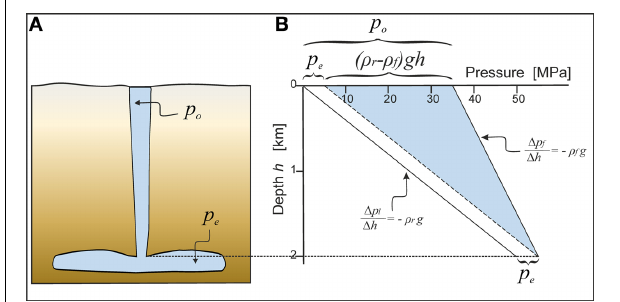
FIGURE 9 | (A) In an elastic crust (cf. Figure 5 ), the weight of the rock above the source is supported by the fluid pressure in the source. In the roof of the source, a lithostatic state of stress is assumed that is, p l = σ 1 = σ 2 = σ 3 . In the fluid source an internal fluid excess pressure p e may occur (in excess of the lithostatic stress), and if p e reaches the local in situ tensile strength T 0 of the rock in the roof, the fluid source ruptures and a hydrofracture is initiated (Equation 3). In the propagating hydrofracture, the fluid pressure in excess of the normal stress on the fracture plane, which for extension fractures is the minimum principal compressive stress, σ 3 , is referred to as overpressure p o . (B) Illustration of the buoyancy effect that leads to the fluid overpressure p o in the hydrofracture being different from the excess pressure p e because the density of the host rock, ρ r , is different from that of the fluid, ρ f . In the roof of the fluid source the total fluid pressure p f at the time of rupture is equal to the sum of the lithostatic stress p l and the excess pressure p e (Equation 3). Assuming a fluid density − 3 (water), according to the weight gradient (cid:3) p f = − ρ ρ f of 1000kg m f g (cid:3) h the fluid pressure inside the hydrofracture decreases upwards with roughly 10MPa km − 1 . The lithostatic stress p l in the host rock, however, decreases according to the equation (cid:3) p l (cid:3) h = − ρ r g and must be zero at the Earth’s surface. Assuming a host rock density ρ r of 2500kg m − 3 (average sedimentary rock), the gradient is roughly 25MPa km − 1 . If the fluid reservoir is located at 2 km depth, the lithostatic stress in the roof of the fluid source is 50MPa, and the fluid overpressure p o at the surface is therefore 35MPa. This overpressure p o depends on the excess pressure p e in the source (here assumed to be 5MPa), and the buoyancy term ( ρ r − ρ f ) g h. The differential stress σ d (Equation 4) is not illustrated here. The size of the shaded area in the diagram indicates that the buoyancy effect increases upwards, so that the hydrofracture aperture also increases upwards, as is indicated in (A)